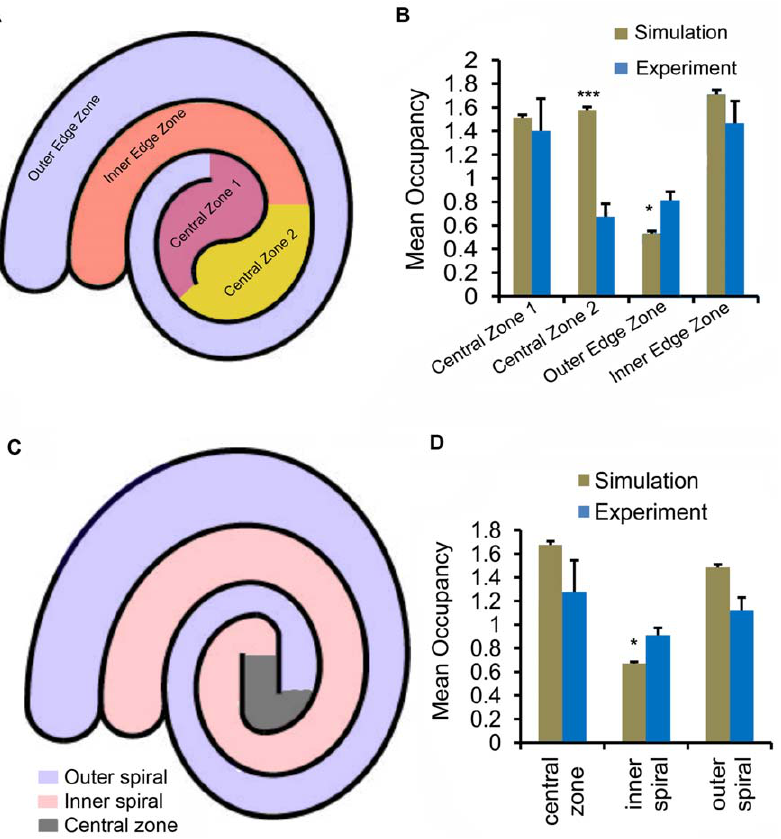
Figure 7. Positional preferences from experiments and simulations in two double spiral arenas. The double spiral arenas are shown in panels A and C . Each arena was divided into different spatial zones. The mean occupancies in these zones for arena A and C are shown in B and D , respectively. In the spiral arenas, the occupancy was computed as a ratio of fraction of total time spent in a zone to the fraction of the total arena occupied by the zone. The asterix indicates significant difference between simulations and experiments (*: p v 0 : 05 , **: p v 0 : 001 , and ***: p v 0 : 0001 ).